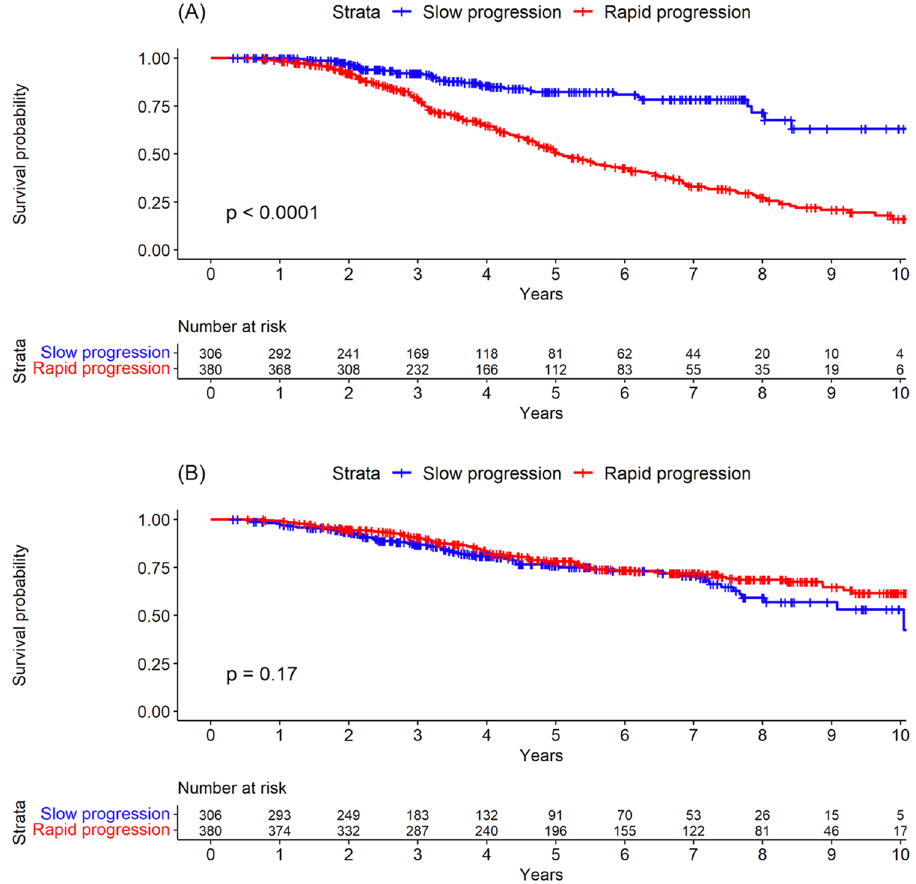
Figure 2. Kaplan–Meier curves for ( A ) aortic valve replacement and ( B ) death according to progression